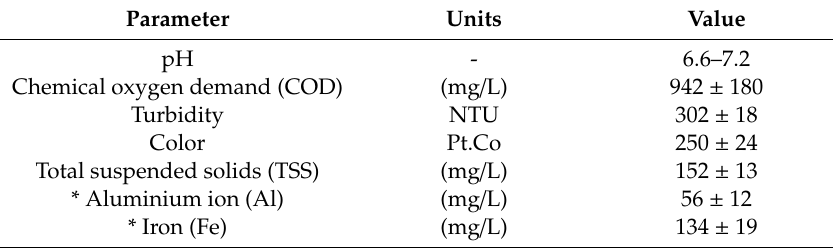
Table 6. Characterized wastewater